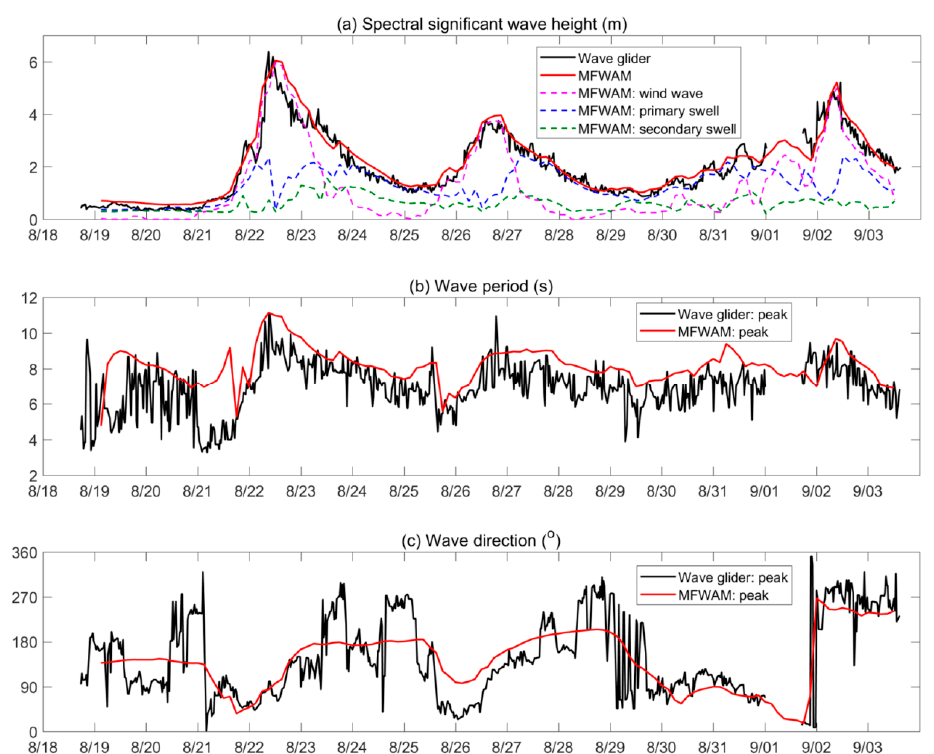
Figure 8. Comparison of wave glider observation and forecast product from the Meteo France WAve Model (MFWAM) ( a – c ).